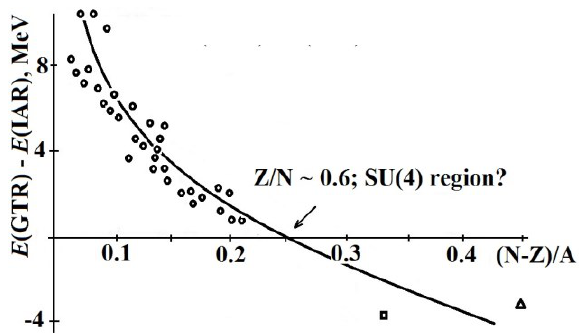
Fig. 4 The difference of the E GTR - E IAR energies (circles) as a function of the neutron excess [1,12]. Data for 6 He (square) [7] and for 11 Li (triangle) β - -decays were